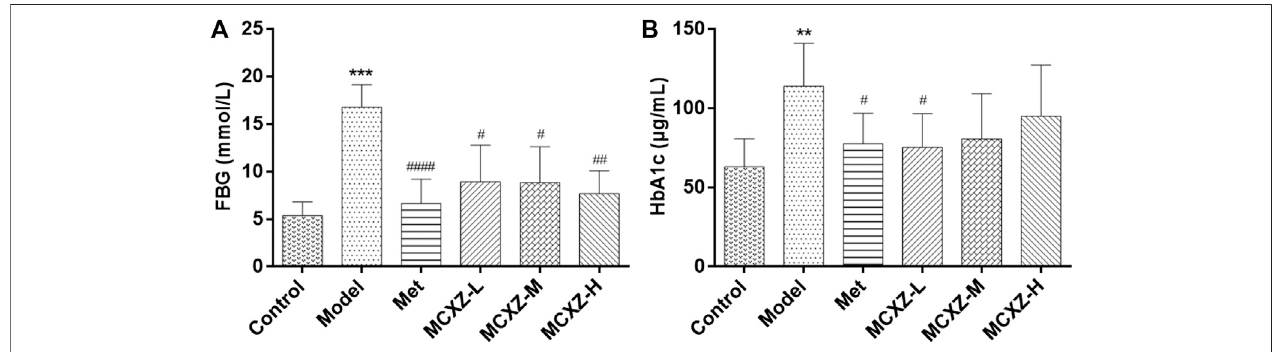
FIGURE2| MCXZalleviatesthesymptomsofthemicewithDM. (A) MCXZreducetheFBGofthemicewithDM. (B) MCXZdownregulatedthelevelofHbA1cinthe serum of mice with DM. MCXZ-L, MCXZ low dose group 812.5 mg/kg; MCXZ-M, MCXZ middle dose group 1625 mg/kg; MCXZ-H, MCXZ high dose group 3250 mg/kg. Data are mean ± SD.*** p < 0.001, ** p < 0.01 vs. Control; #### p < 0.0001, ## p < 0.01, # p < 0.05 vs. the modle group; n (cid:2) 8 – 12 animals per